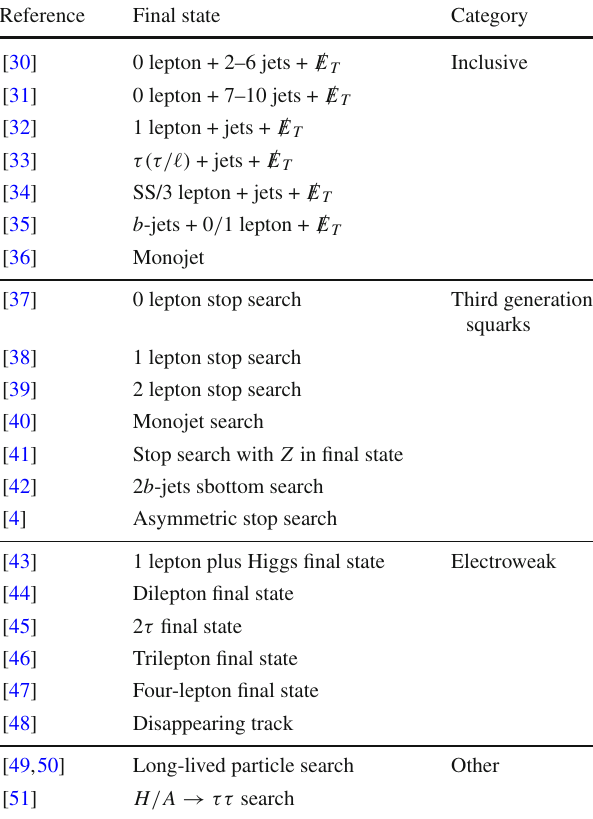
Table 1 The experimental analyses used in the ATLAS study [6]. The middle column denotes the final state for which the analysis is opti- mized, and the third column shows the target scenario of this